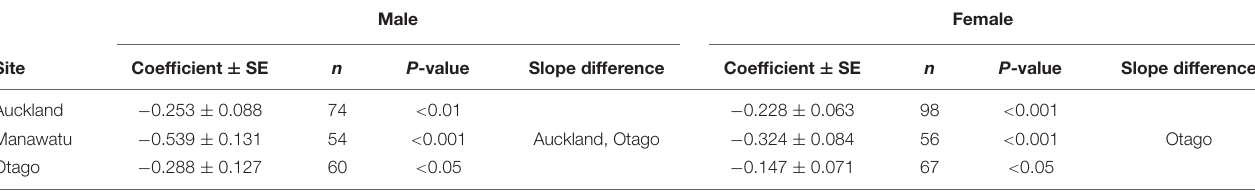
TABLE 3 | Slopes of the relationships between northward migration date and bill length for bar-tailed godwits in New Zealand. Male Female Site Coefficient ± SE n P -value Slope